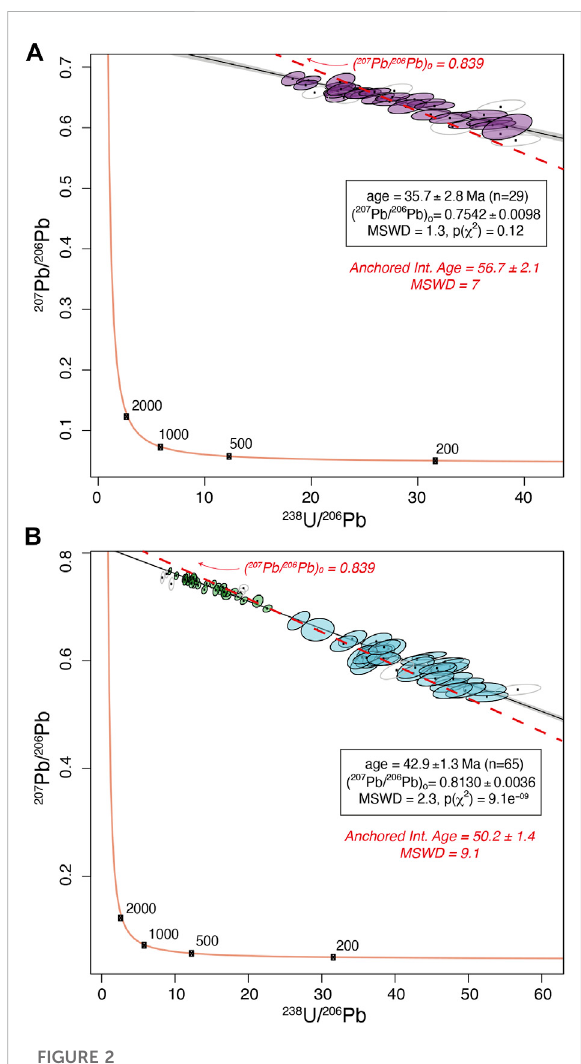
FIGURE 2 Tera-Wasserburg concordia diagrams forU-Pb datingofCFA in the Moroccan High Atlas. (A) AMZ13 sample. (B) AMZ9 (green) and AMZ8 (blue) samples. Black lines represent unanchored discordias. Following the Pb model of Stacey and Kramers (1975), red dashed-lines represent anchored discordias that were calculated with an initial ( 207 Pb/ 206 Pb) 0 ratio of 0.839, corresponding to an emplacement age of ~60 Myr. Un fi lled ellipses were excluded from age calculations. Ellipses and errors are reported at 2 σ . MSWD: Mean Squared Weighted